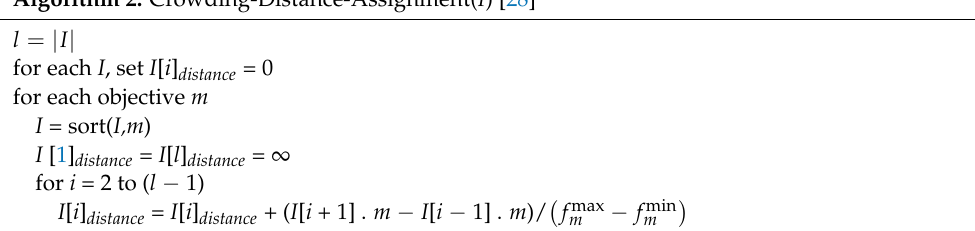
Algorithm 2. Crowding-Distance-Assignment( I )